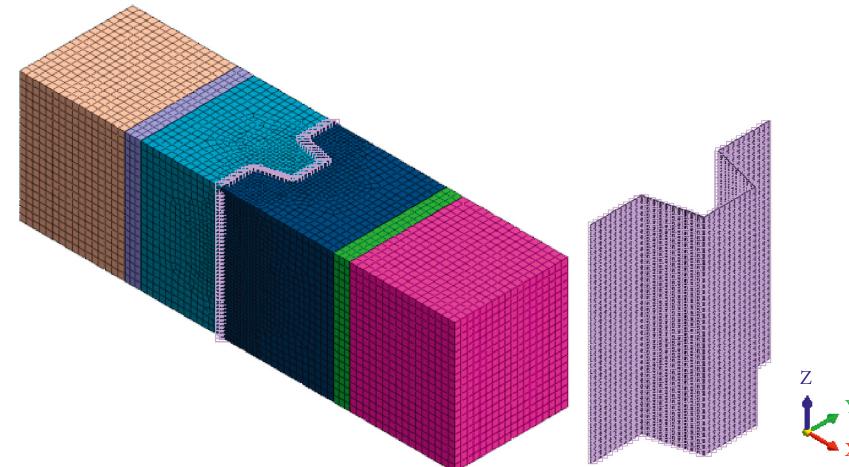
Figure 9: Numerical model of long tenon without grout (same as experimental specimen).